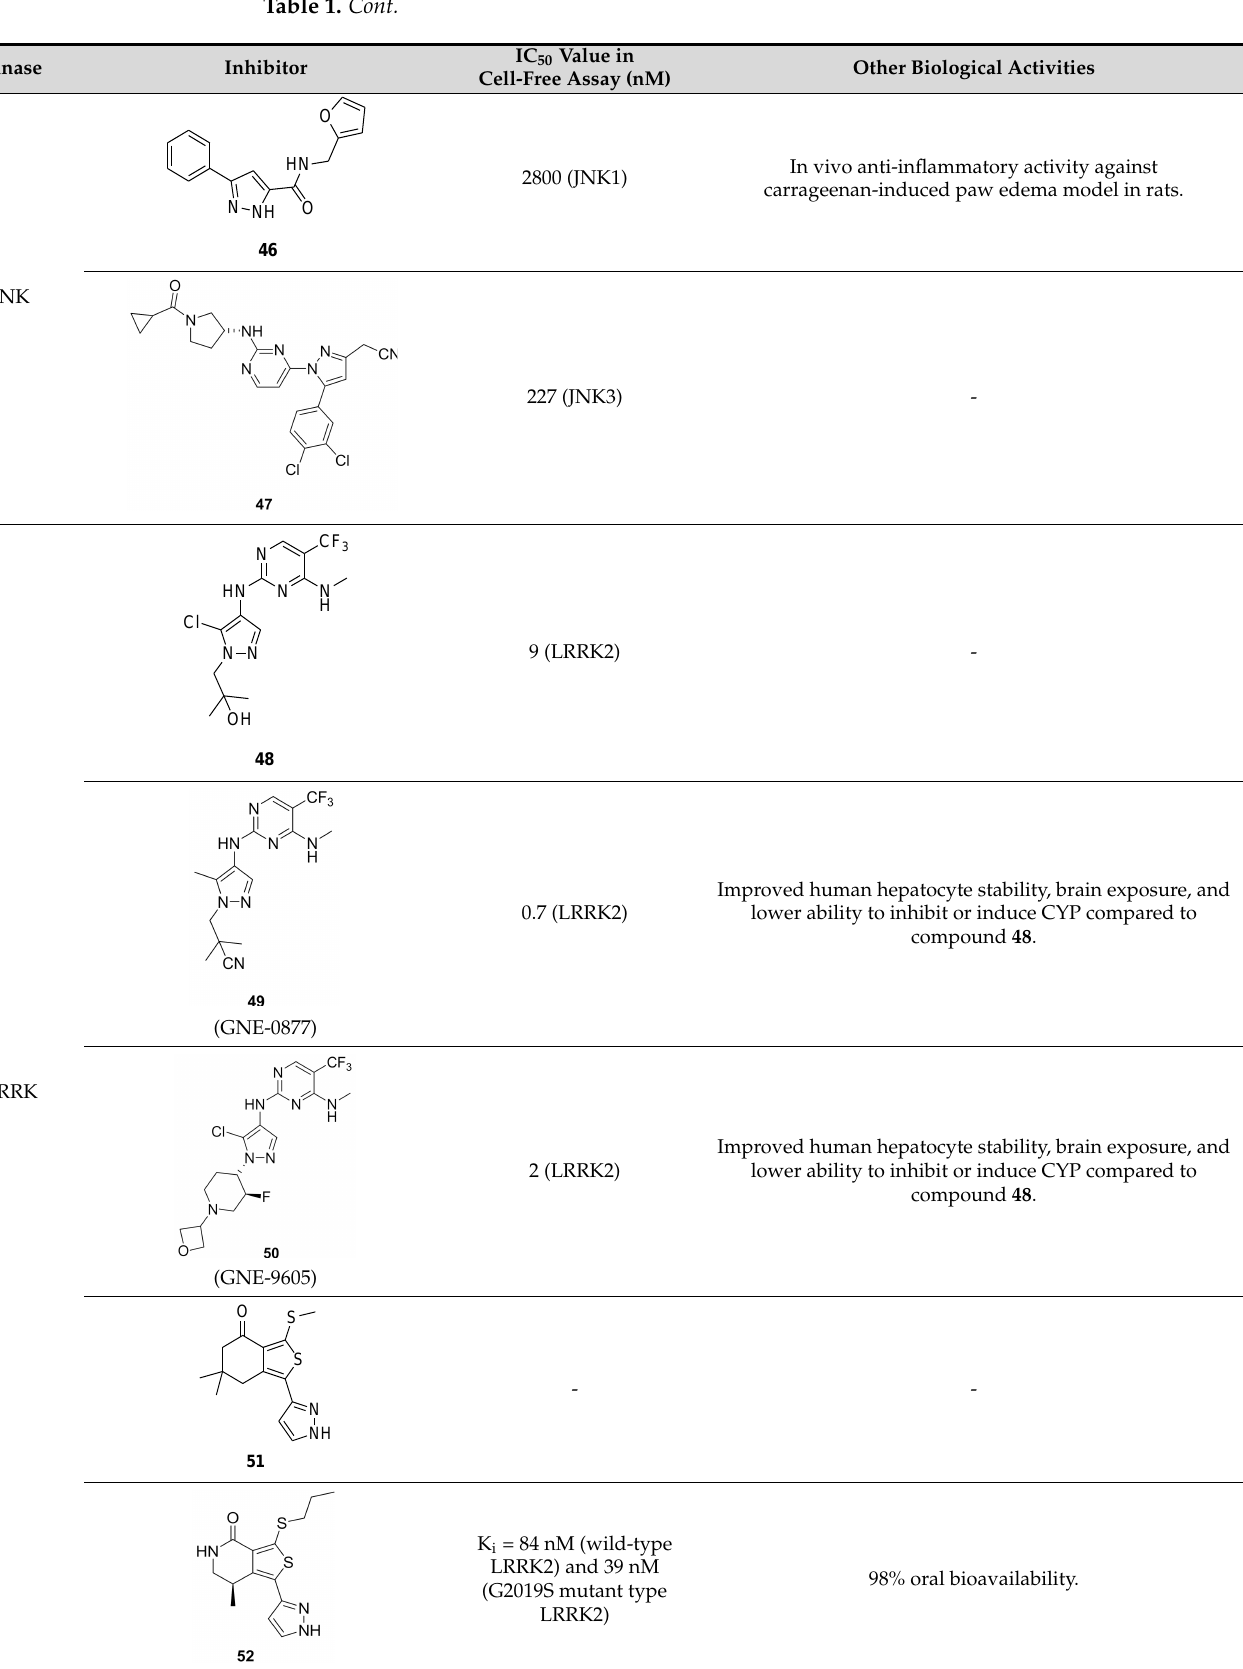
Improved human hepatocyte stability, brain exposure, and lower ability to inhibit or induce CYP compared to compound 48.